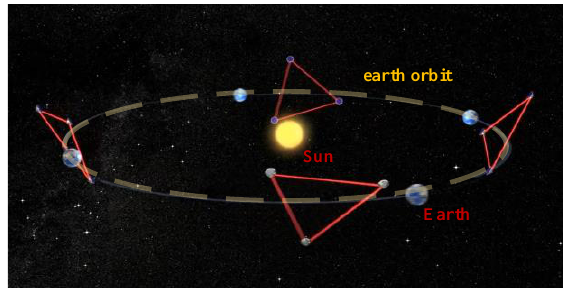
Figure 5. Space orbit schematic of LISA.